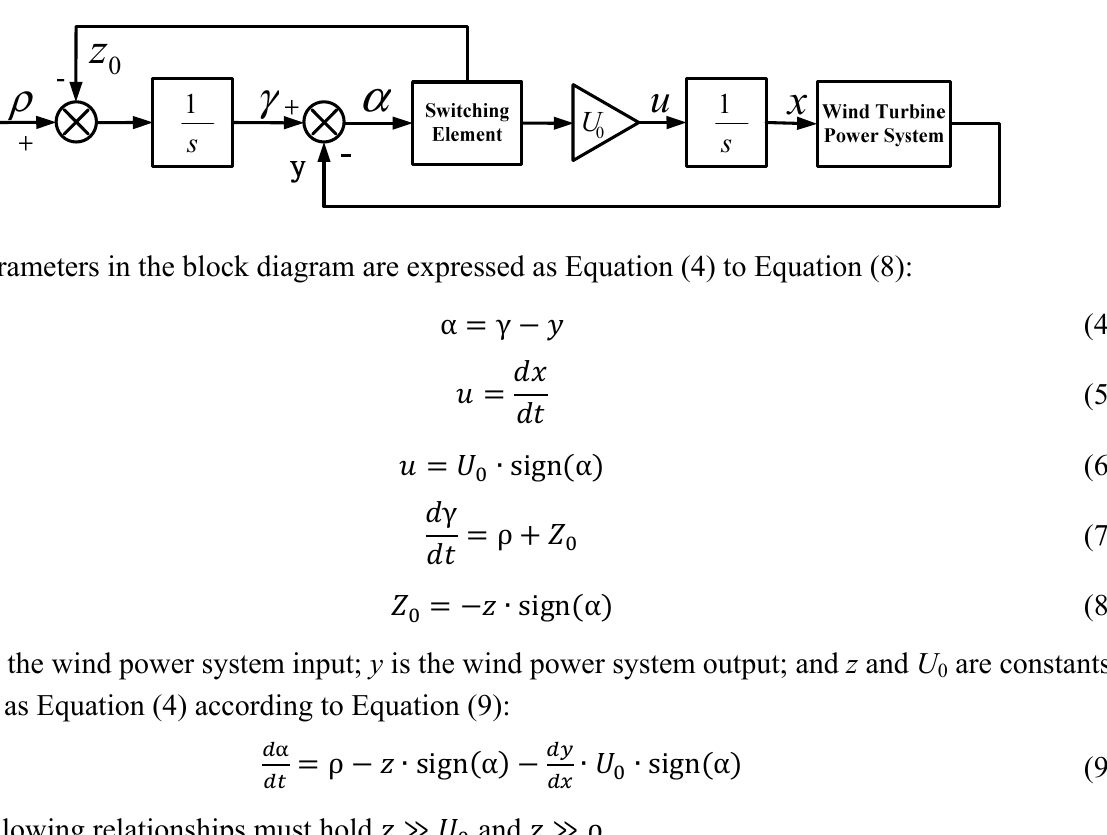
Figure 8. Wind power sliding mode extremum seeking control (SMESC) block